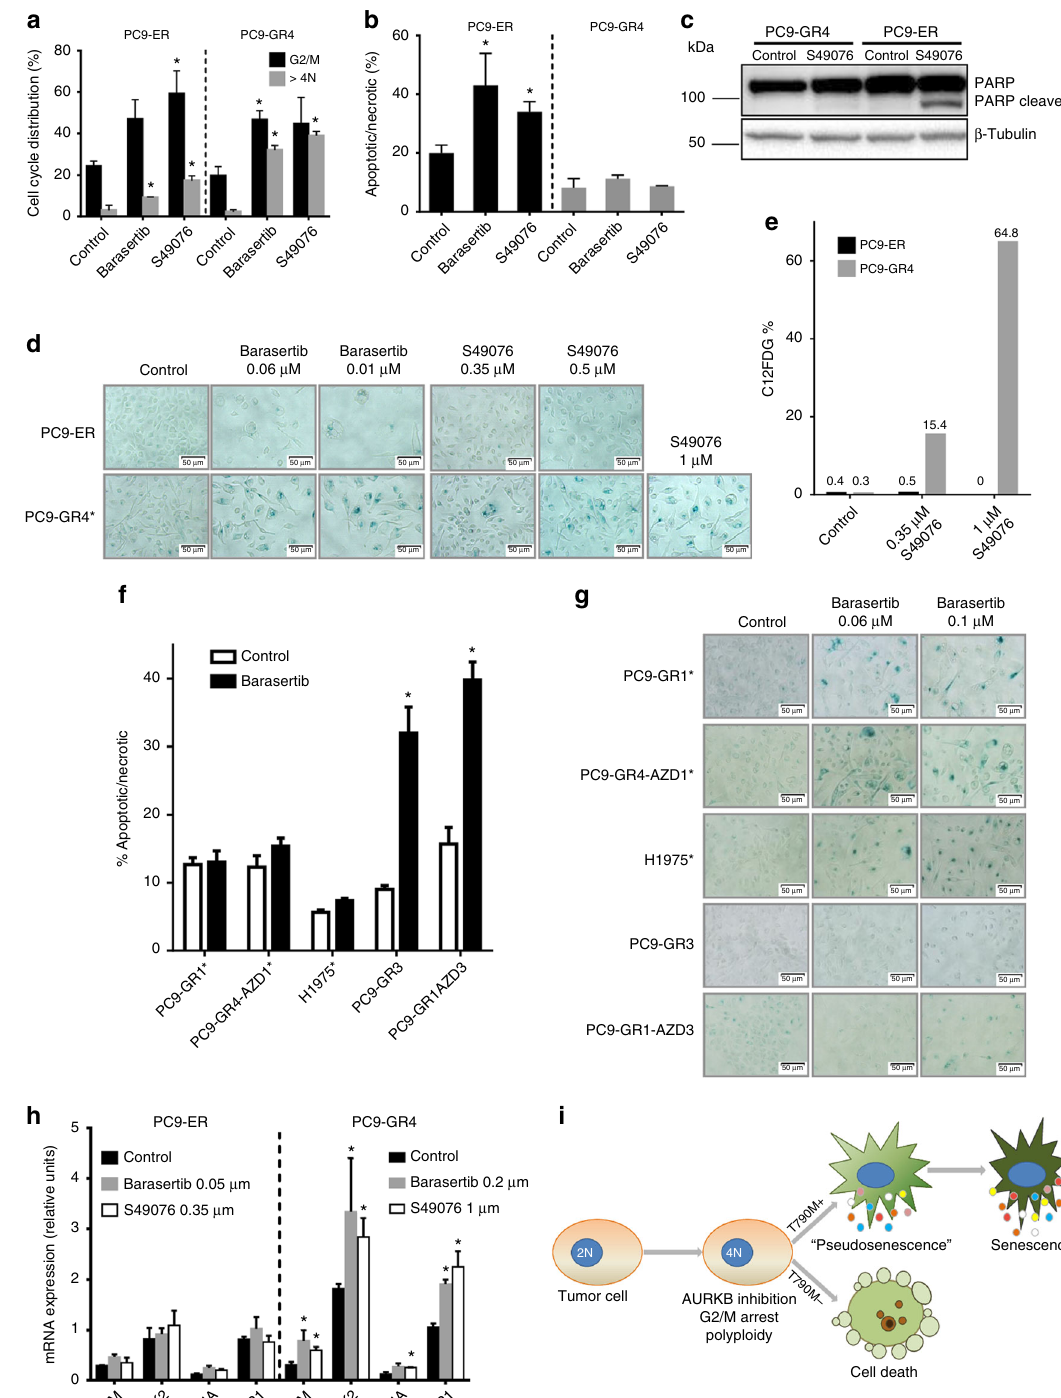
effects only in absence of p.T790M or NRAS mutations. Annexin V analyses revealed that both drugs induced apoptosis exclusively in p.T790M and NRAS -negative resistant cells. In positive cells, AURKB inhibition and polyploidy were fol- lowed by profound changes characteristic of the senescent phenotype, which were clearly observable after 2 days and included growth arrest, enlarged cellular size, cell fl attening, irregular nuclei and overexpression of acidic β -galactosidase. However, if barasertib at <0.2 µM or S49076 at <1 µM were